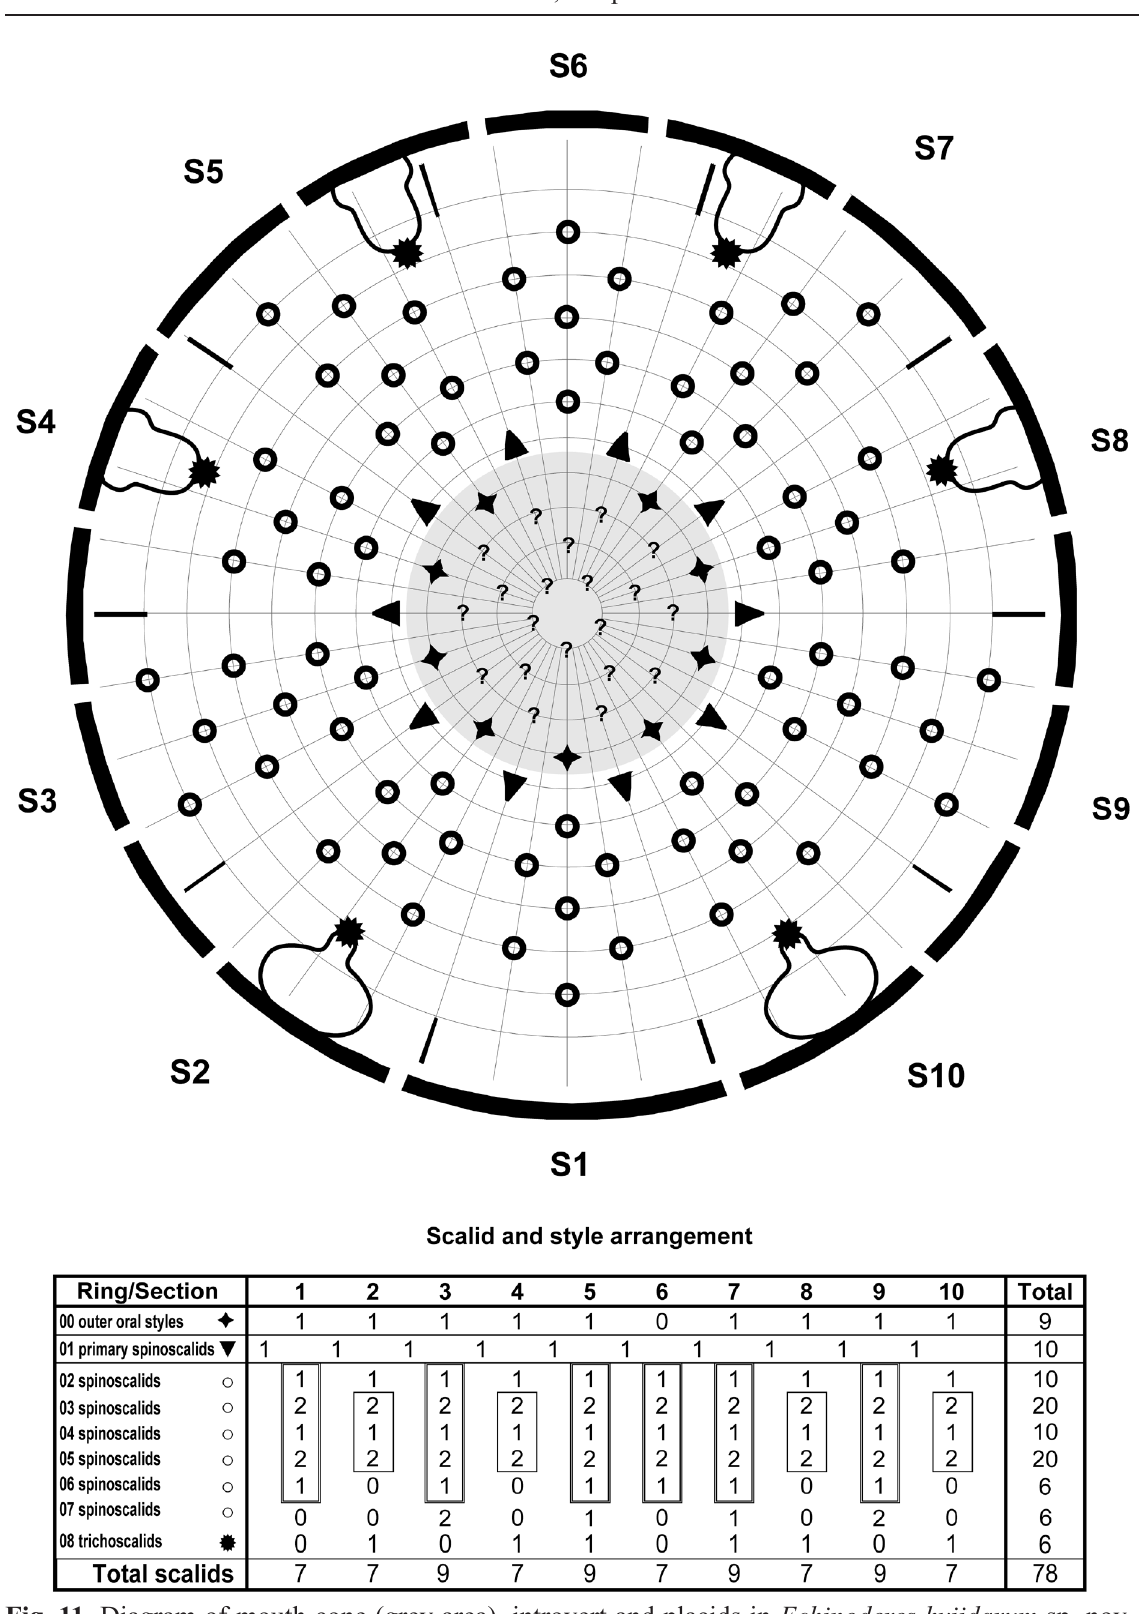
Fig. 11. Diagram of mouth cone (grey area), introvert and placids in Echinoderes hviidarum sp. nov., showing distribution of outer oral styles, scalids and trichoscalids. Table shows the scalid arrangement by sector; single-lined boxes mark quincunxes, double-lined boxes mark “double